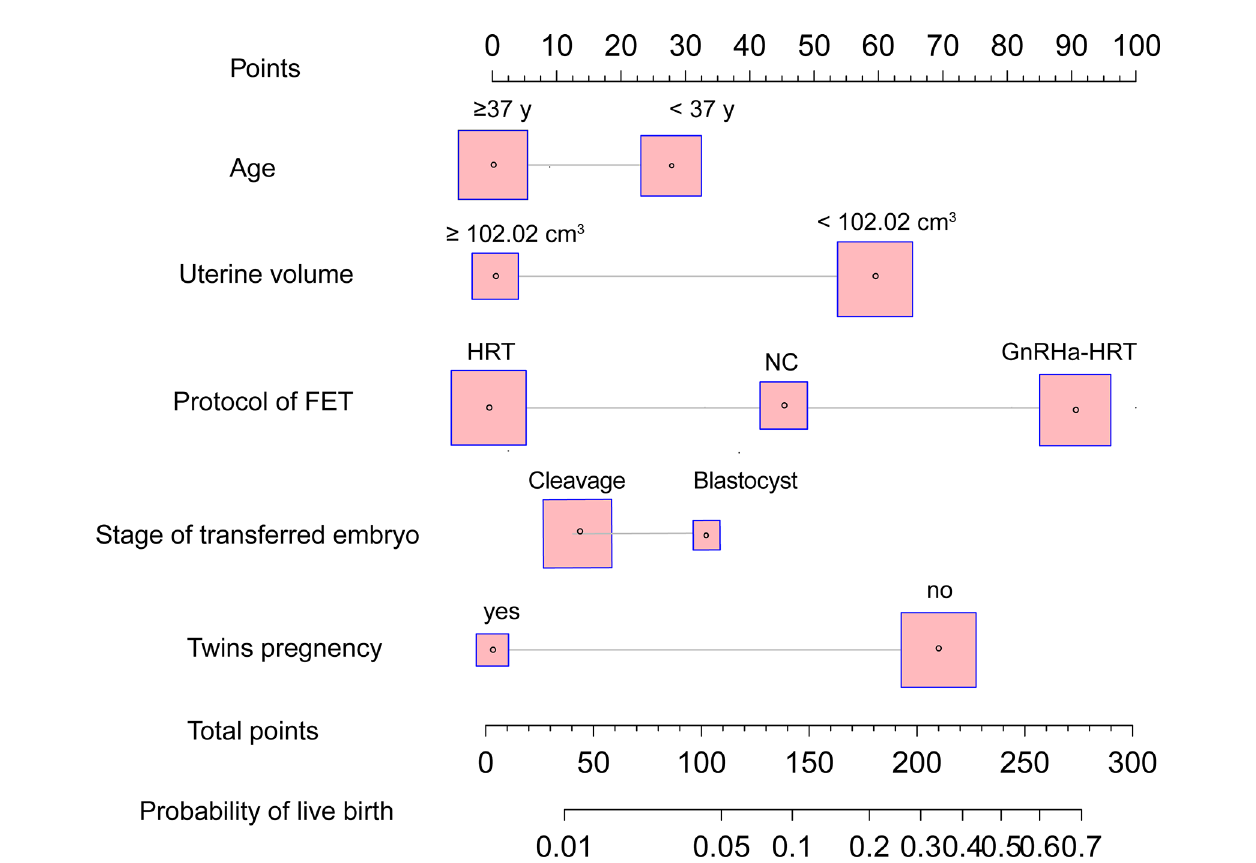
FIGURE 2 | Nomogram to predict the probability of live birth in adenomyosis-related infertility patients undergoing FET. The probability of a live birth is calculated by drawing a line to the point on the axis for each of the following variables: stage of transferred embryo, age, twin pregnancy, protocol of FET, and uterine volume prior to ET. The points for each variable are summed up and located on the total points line. Next, a vertical line is projected from the total points line to the predicted probability bottom scale to obtain the individual probability of a live birth. FET, frozen – thawed embryo